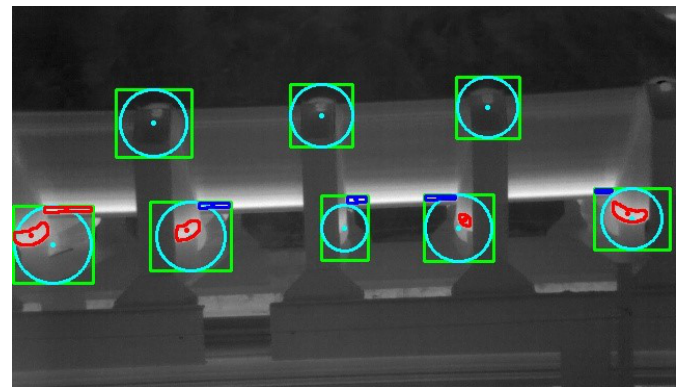
Figure 12. Defective regions found through the distance threshold approach.